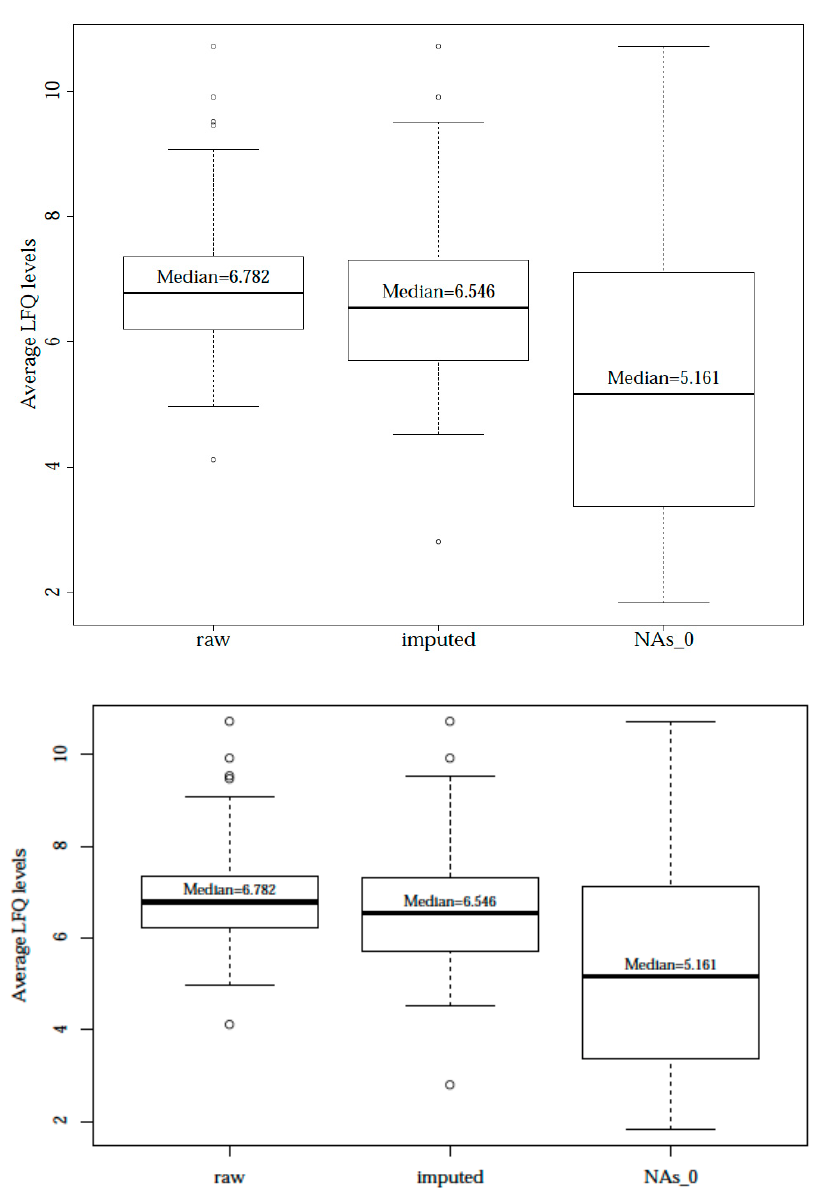
Figure 2. Boxplots of average protein LFQ levels after different NA replacement. Comparison of mean LFQ protein values in different data (raw, imputed, and NAs replaced by 0). Replacement by 0 differed significantly from the raw data ( p < 0.0001).